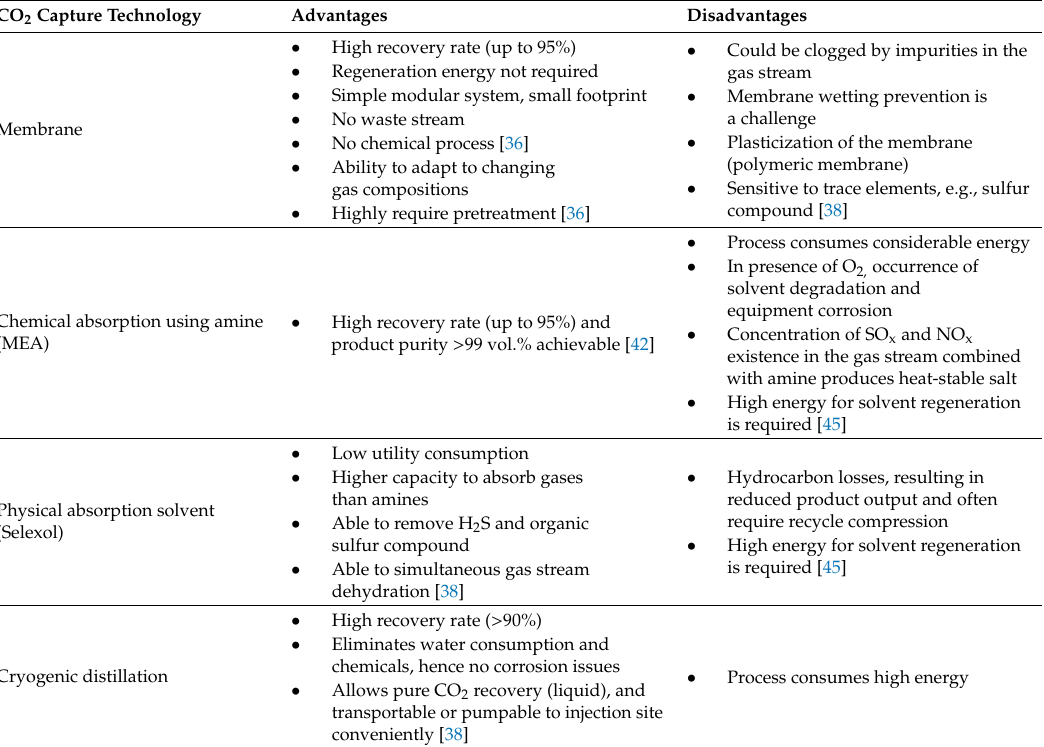
Table 1. Advantages and disadvantages of the selected CO 2 capture